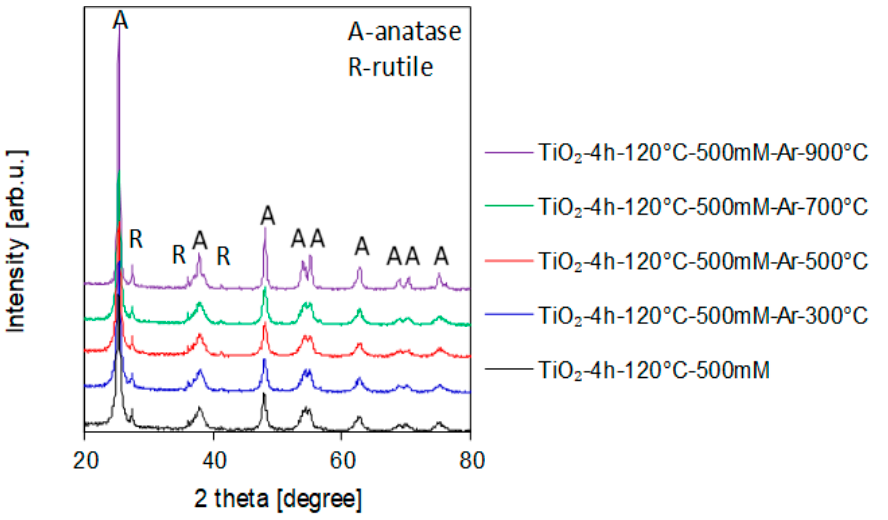
Figure 1. X-ray diffraction (XRD) patterns of 3-aminopropyltriethoxysilane (APTES)-modified TiO 2 before and after the calcination process.